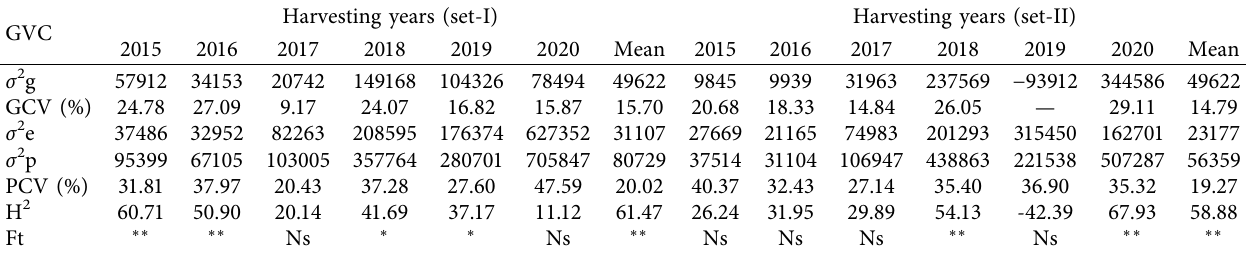
Table 4: Variance components and heritability of coffee yield for six harvesting seasons.